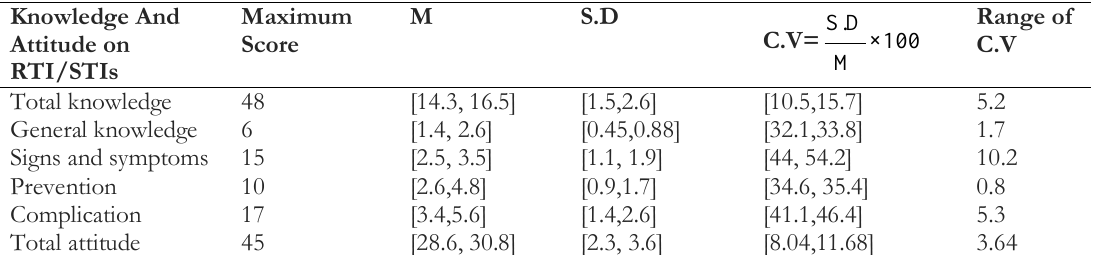
Table 6. Knowledge and attitude on RTI/STIs